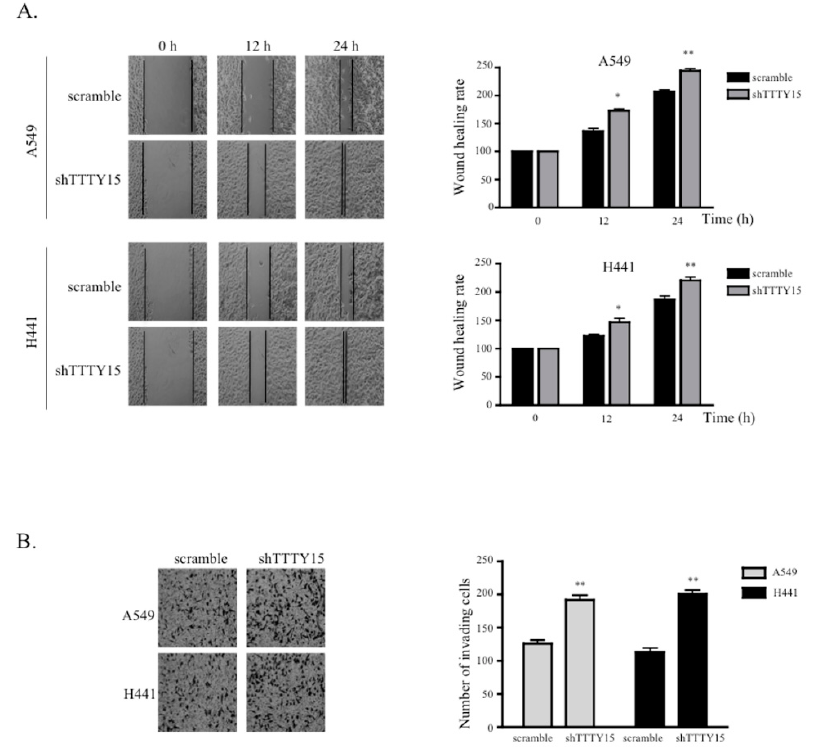
Figure 3. The TTTY15 knockdown increases cell migration and invasion. ( A ) Wound scratch assays were performed to analyze the migration efficiency of TTTY15 knockdown A549 and H441 cells compared to the scramble cells. The statistical analysis of the inhibition rates of A549 and H441 cells was performed at 12 and 24 h, respectively. Magnification, ×200. ( B ) The Transwell invasion assay was performed to determine the invasion ability of TTTY15 knockdown A549 and H441 cells compared to the scramble cells. Data are presented as the mean ± SD; * p < 0.05, ** p < 0.01. Statistical analysis was conducted by Student’s t -test ( n = 3).